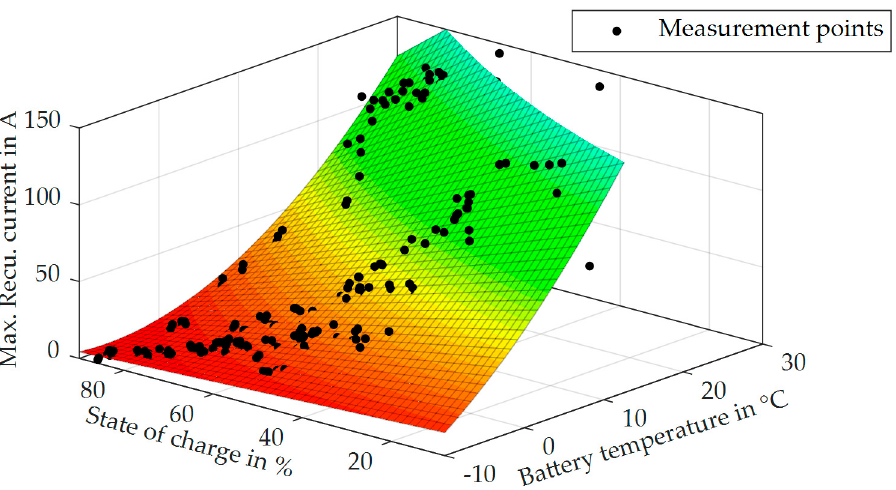
Figure 5. Maximum battery recuperation current depending on battery temperature and state of charge (SoC).